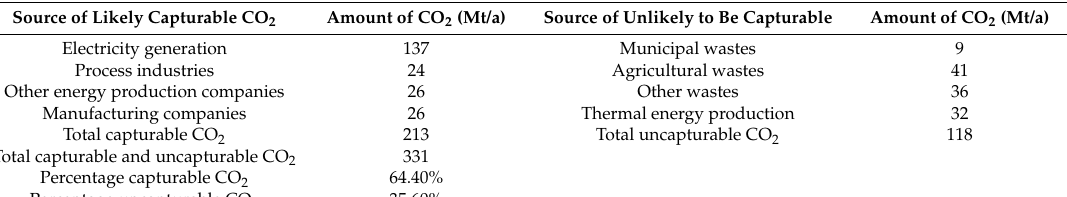
Table 2. Sources of CO 2 emissions in South Africa [35–37].